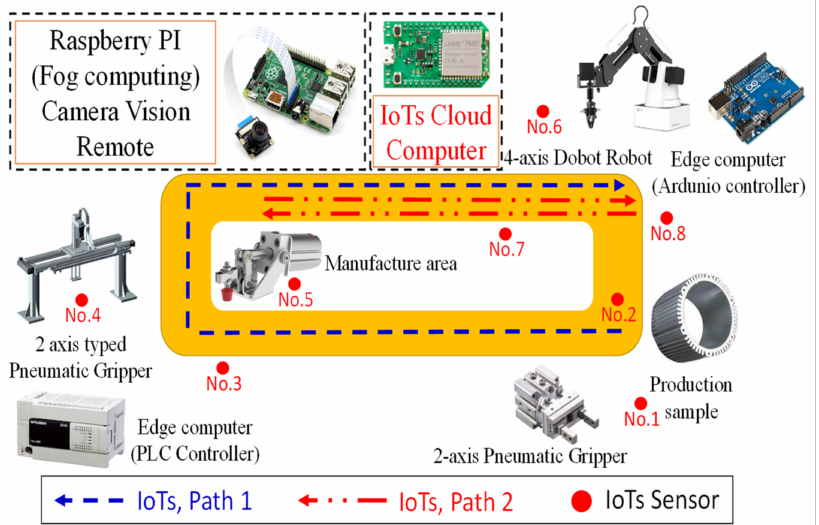
Figure 3. Schematic diagram of the physical architecture of the automated production